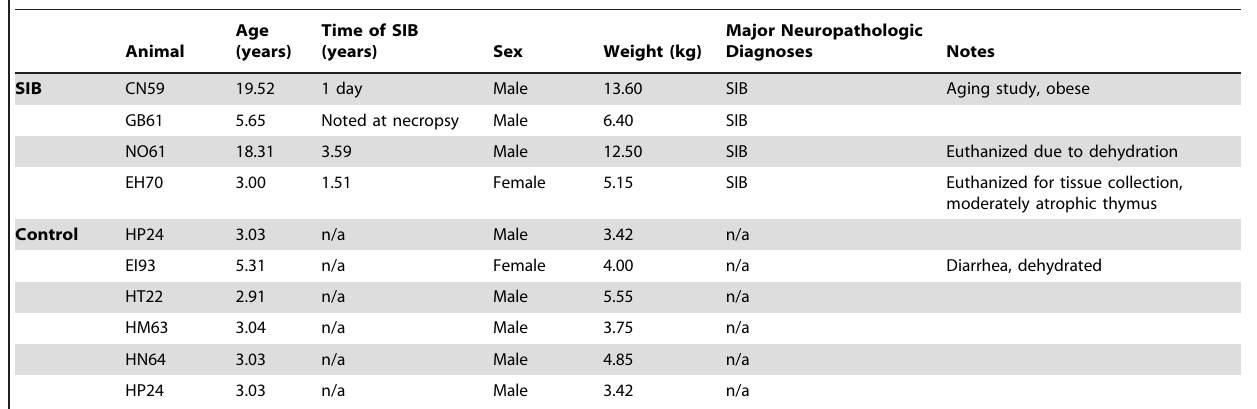
Table 1. List of SIB and Control Animals.